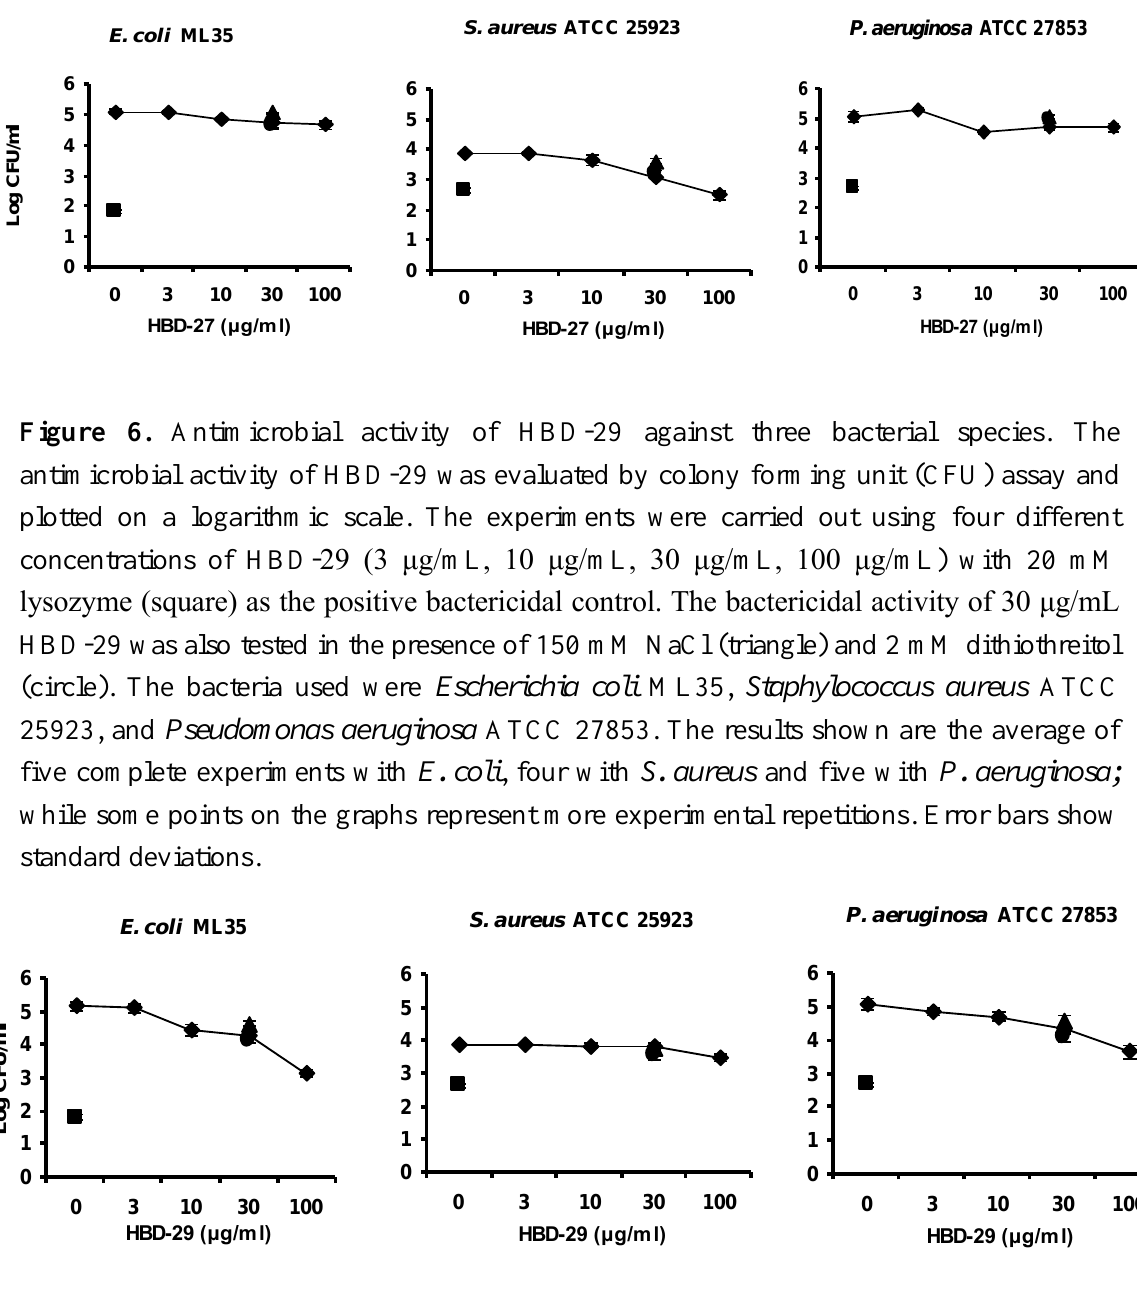
Figure 5. Antimicrobial activity of HBD-27 against three bacterial species. The antimicrobial activity of HBD-27 was evaluated by colony forming unit (CFU) assay and plotted on a logarithmic scale. The experiments were carried out using four different concentrations of HBD-27 (3 μg/mL, 10 μg/mL, 30 μg/mL, 100 μg/mL) with 20 mM lysozyme (square) as the positive bactericidal control. The bactericidal activity of 30 μg/mL HBD-27 was also tested in the presence of 150 mM NaCl (triangle) and 2 mM dithiothreitol (circle). The bacteria used were Escherichia coli ML35, Staphylococcus aureus ATCC 25923, and Pseudomonas aeruginosa ATCC 27853. The results shown are the average of six complete experiments with E. coli , six with S. aureus and five with P. aeruginosa; while some points on the graphs represent more experimental repetitions. Error bars show standard deviations.